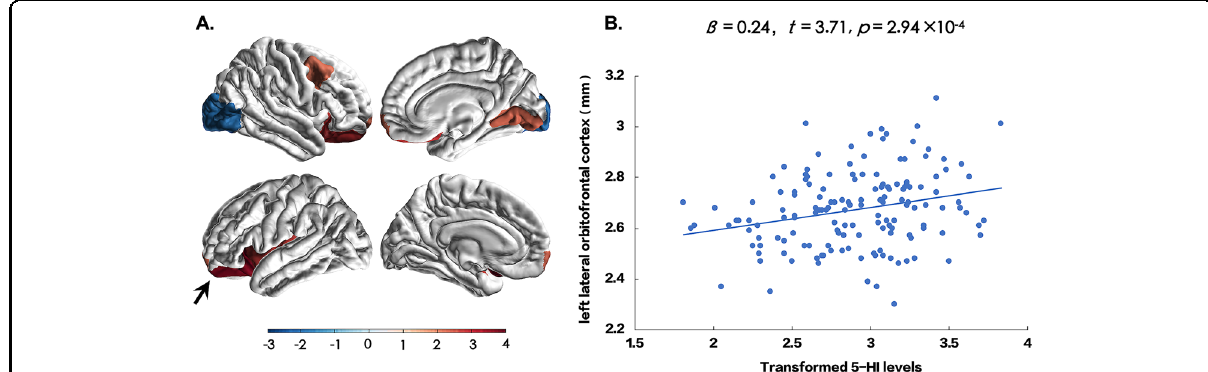
Fig. 4 The relationship of serum levels of 5-HI with cortical thickness in patients with schizophrenia. The left and right frontal poles, left insula, right caudal-middle frontal, left and right lateral orbitofrontal, and right lingual areas were positively and signi fi cantly associated with 5-HI at p = 0.03 – 0.0003, and the right lateral occipital region was inversely associated with 5-HI at p = 0.05, but only the lateral orbitofrontal cortex (arrow) was signi fi cant after correction for multiple comparisons. A Cortical regions were colored according to t -scores by multiple linear regression. The color bar represents t -scores. B Scatter plot between 5-HI and the left lateral orbitofrontal cortex (arrow in A ) in patients with